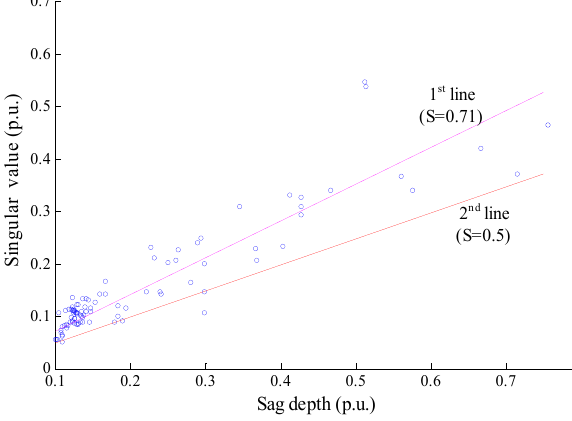
Figure 7. The relation between singular values and sag depth.